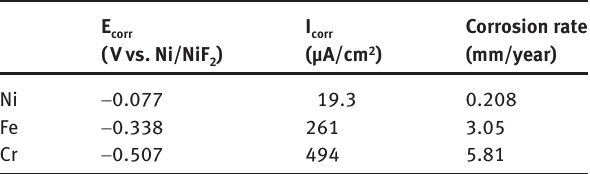
Table 1: Fitting results of polarization curves for Ni, Cr and Fe in molten (Li,Na,K)F at 973 K